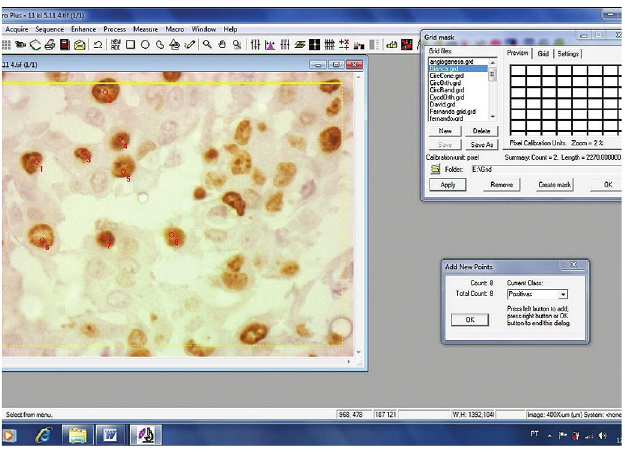
figurE − Image of screen capture of Image Pro Plus 6.0 software with the file of cells brown stained with Ki-67 antibody. Each field had the number of cells and the stained area counted. DAB dye, 400× DAB: